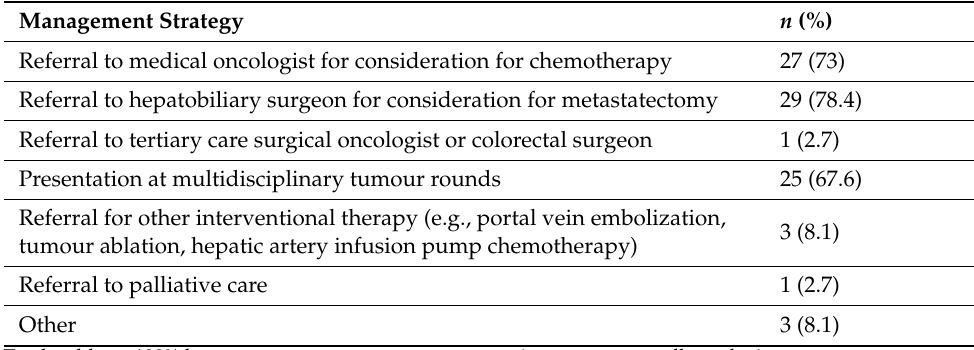
Table 2. Current management strategies for patients with colorectal liver